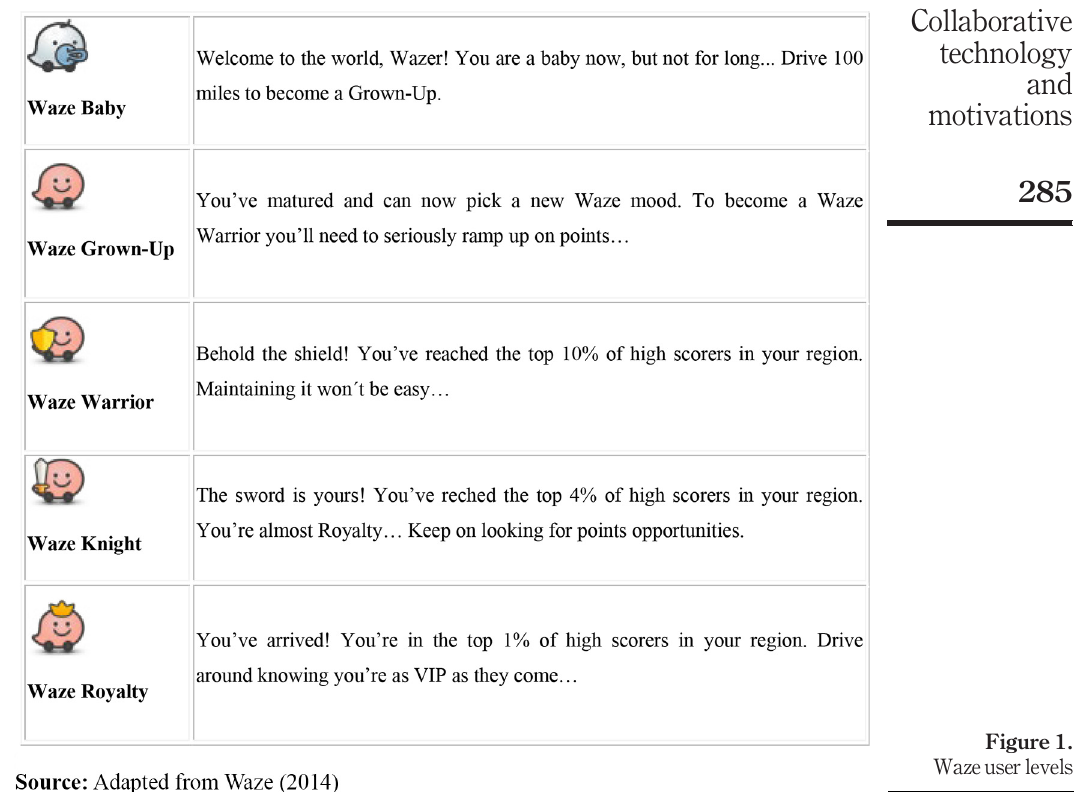
Figure 1. Waze user